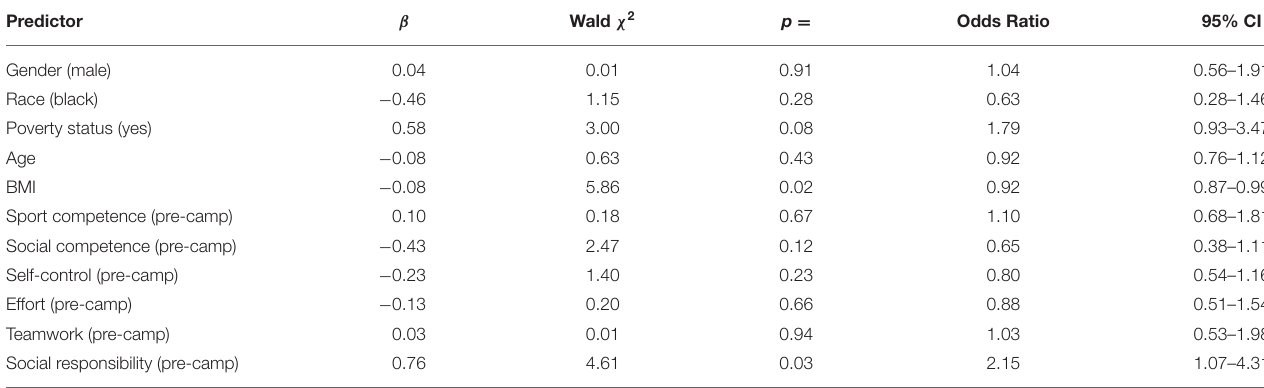
TABLE 2 | Logistic regression results predicting returning status from characteristics entering camp.